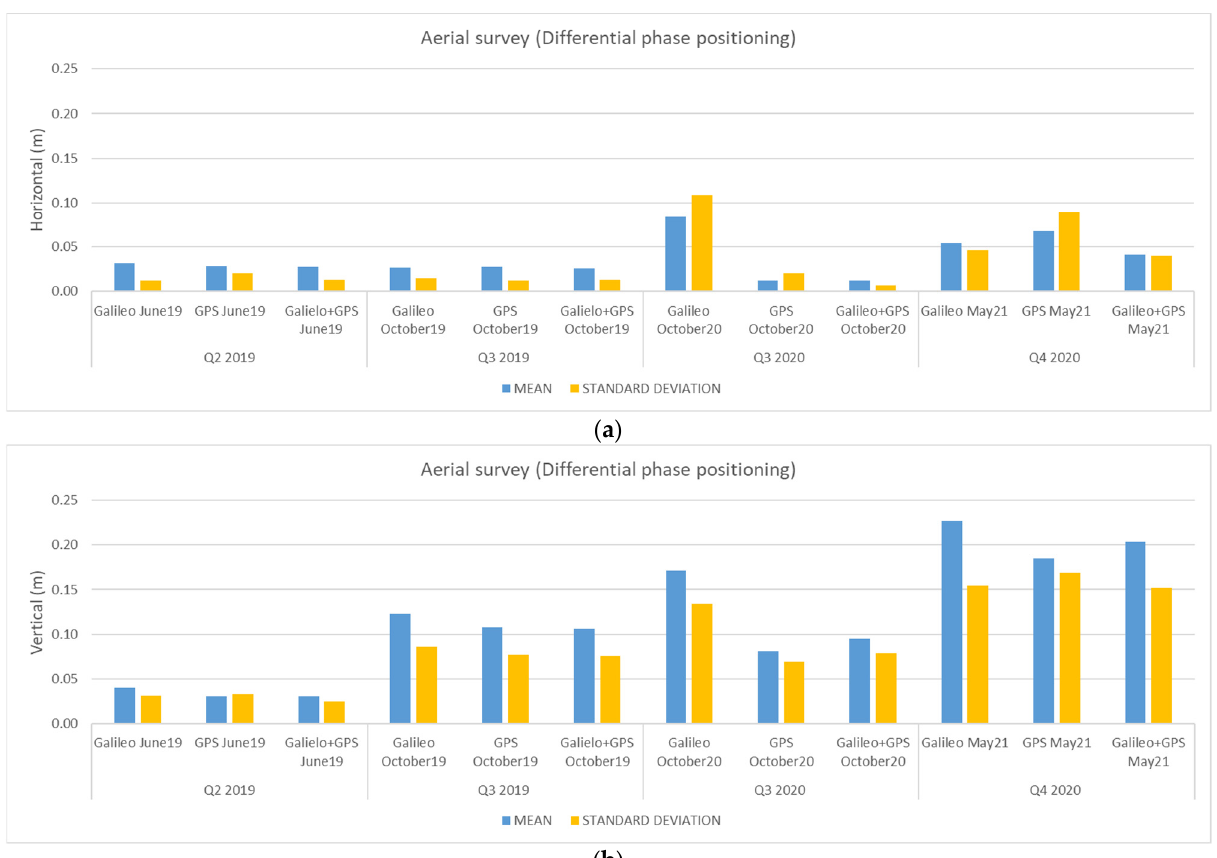
Figure 8. Horizontal ( a ) and vertical ( b ) mean values and standard deviations (in meters) for the triple-frequency differential solutions in the different aerial campaigns using CSRS-PPP as reference.